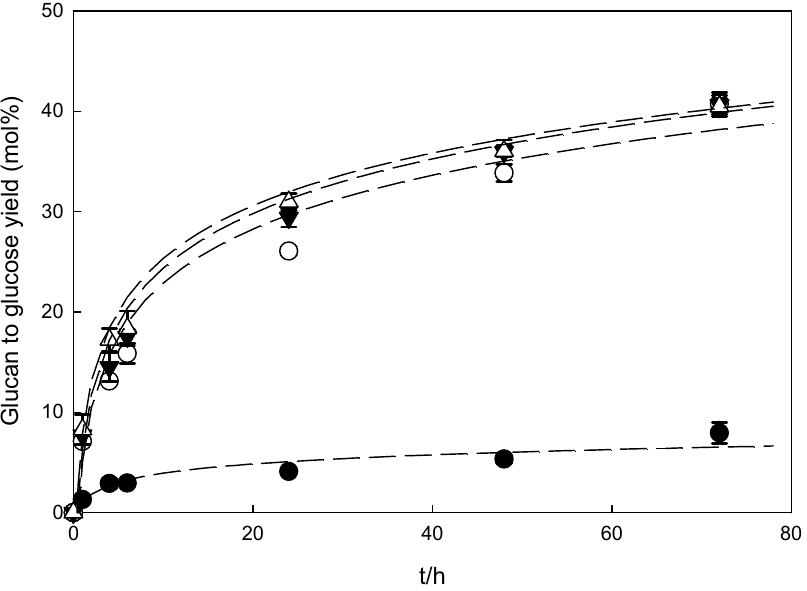
Figure 6. Glucan to glucose yields that were produced by an imidazole pre-treatment of eucalyptus residues. The enzymatic hydrolyses were performed at 2% ( w / v ) total solids with 60 FPU/g glucan of Cellic CTec2. The dashed lines are only used as a guide for the eye and have no physical